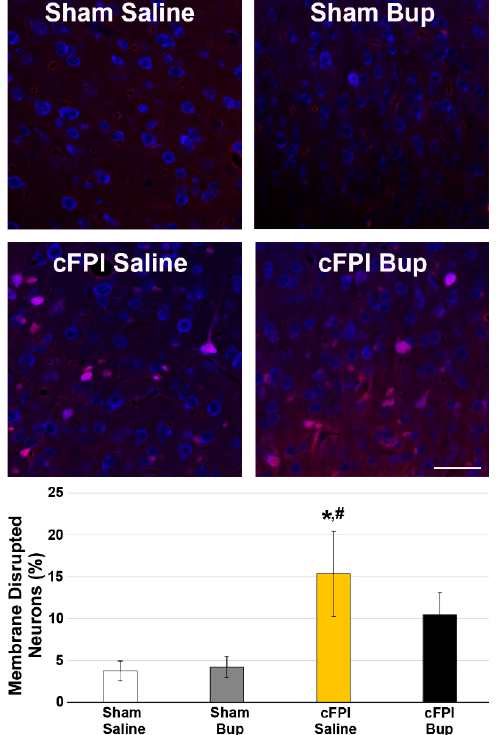
Figure 3. Treatment with Bup-SR-Lab (Bup) did not impact cortical neuronal membrane disruption. Representative photomicrographs of neuronal membrane disruption in the lateral neocortex of rats treated with saline or Bup. Cell uptake of the cell-impermeable 10 kDa fluorescently tagged dextran (red) indicated neurons sustaining membrane disruption. Neurons were visualized with NeuroTrace fluorescent Nissl stain (blue). Corresponding bar graph depicting the percentage of total neurons that demonstrated membrane disruption in saline and Bup treated animals following Sham or central fluid percussion injury (cFPI). The percentage of dextran + neurons was consistent between injury groups, indicating that buprenorphine treatment did not affect the percentage of membrane disrupted neurons in the cortex. n = 4–6 rats/group. Mean ± SEM. Scale = 50 µ m. * p < 0.05 compared to sham saline cortex, # p < 0.05 compared to sham Bup cortex. Table 2. Cytokine concentrations (pg/mL) in cortex and thalamus of saline and Bup-SR-Lab treated rats at 4w following Sham or cFPI.